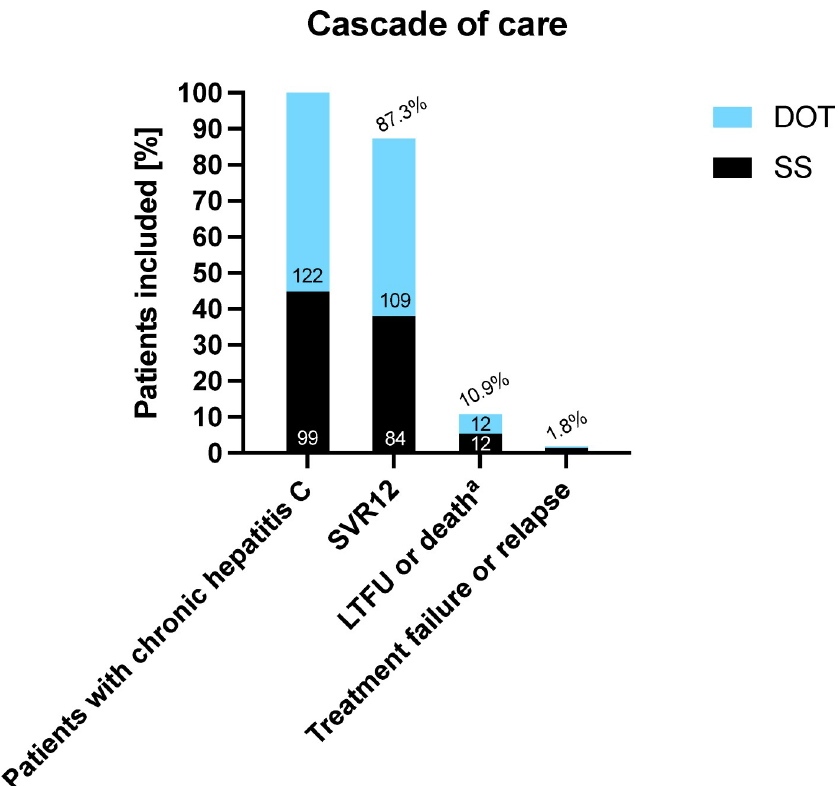
Fig 2. Cascade of care. Abbreviations: SS, standard setting; DOT, directly observed therapy; SVR, sustained virologic response; LTFU, lost to follow-up. a for reasons not related to therapy.